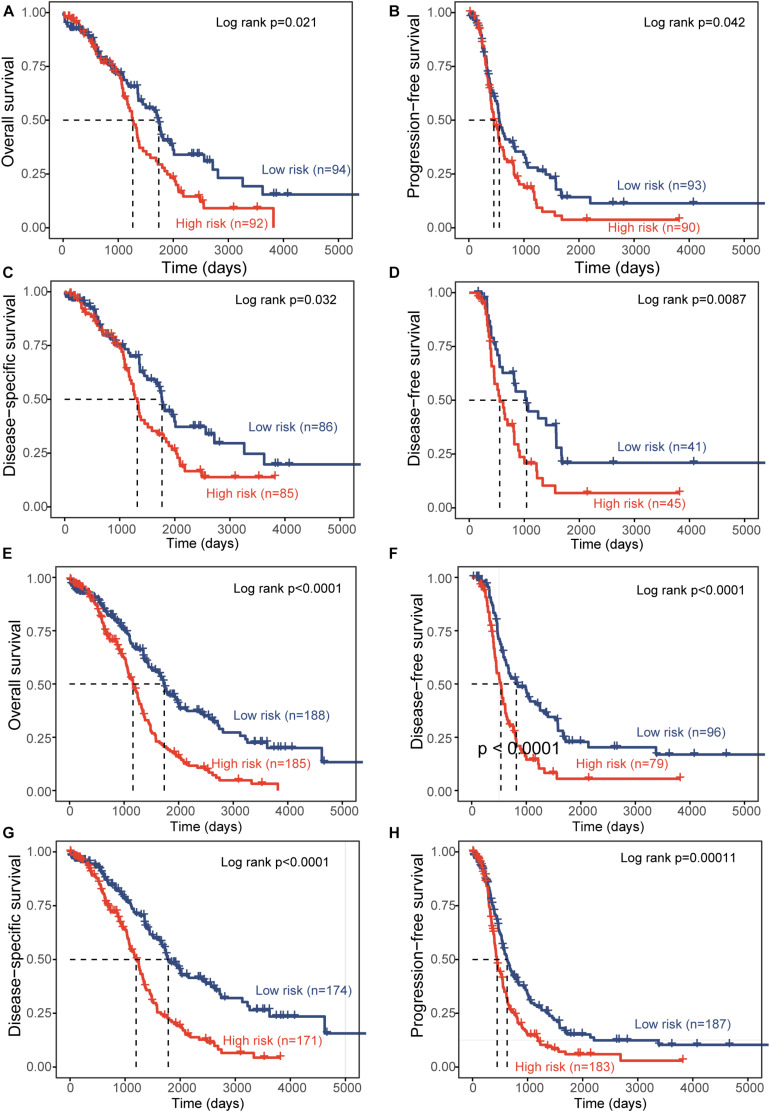
Independent validation of prognostic performance of epigenetically regulated lncRNA signature. Kaplan-Meier survival curves between the high-risk group and low-risk group for overall survival (A), progression-free survival (B), disease-specific survival (C), and disease-free survival (D) in the independent patient cohort. Kaplan-Meier survival curves between the high-risk group and low-risk group for overall survival (E), disease-free survival (F), disease-specific survival (G), and progression-free survival (H) in the entire TCGA-OV patient cohort.